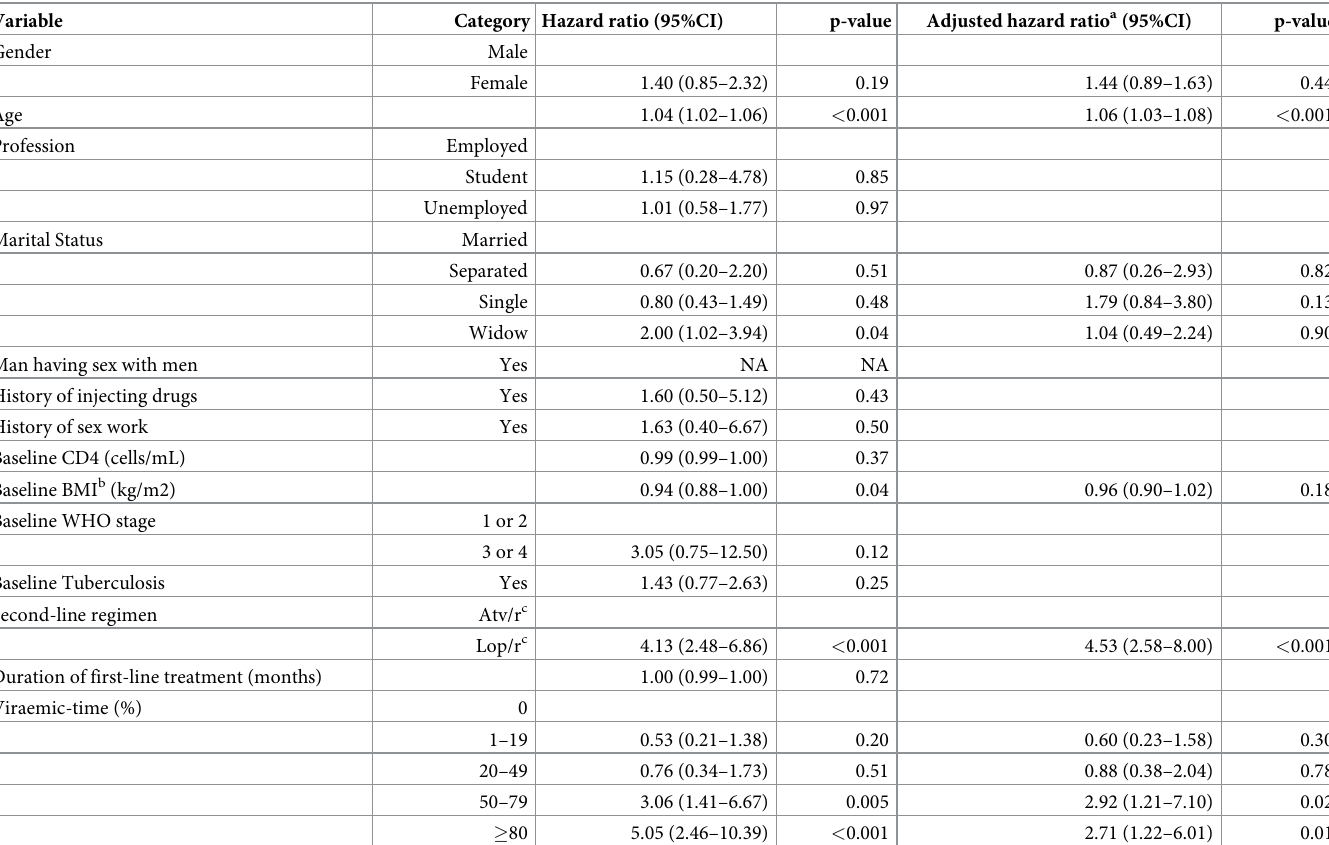
Table 4. Univariable and multivariable Cox regression to show the association between explanatory variables and mortality.